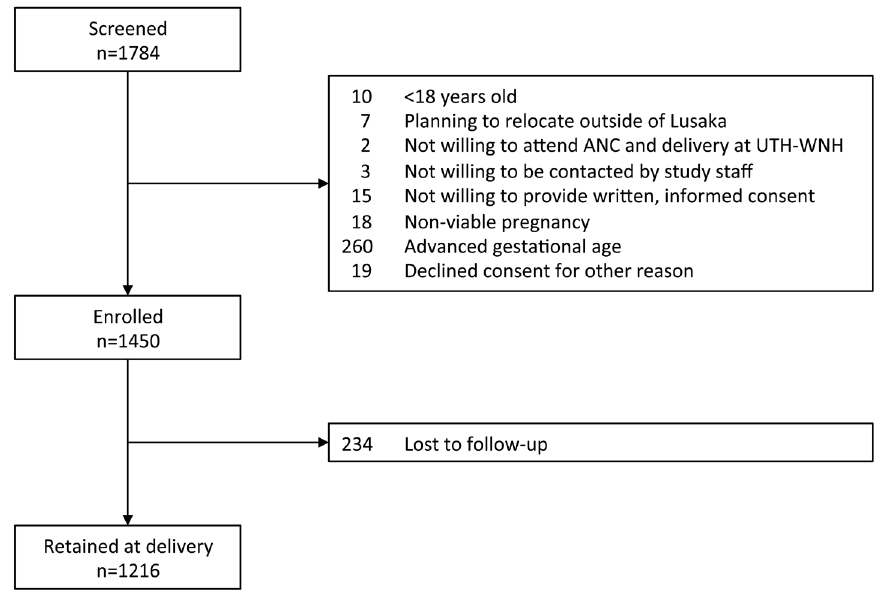
Figure 1. ZAPPS cohort participant flowchart. ANC, antenatal care; UTH-WNH, Women and Newborn Hospital of University Teaching Hospital.